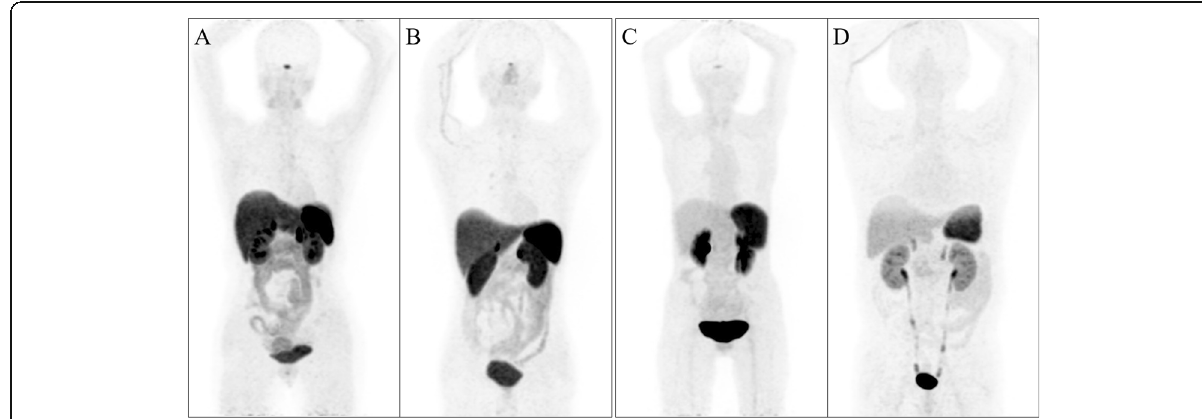
Fig. 5 Representative maximum-intensity PET/CT projection images of 68 Ga-DOTA-TATE ( a , b ) and 68 Ga-NOTA-TATE ( c , d ) in healthy volunteers 35 – 45 min after injection. a Female, 46 years old, 51 kg. Maximum intensity projection image after intravenous injection of 68 Ga-DOTA-TATE (2.52 mCi) (pituitary, SUVmax = 7.74; spleen, SUVmax = 25.5; liver, SUVmax = 9.4; kidney, SUVmax = 13.9). b Male, 37 years old, 58 kg. Maximum intensity projection image after intravenous injection of 68 Ga-DOTA-TATE (2.80 mCi) (pituitary, SUVmax = 4.2; spleen, SUVmax = 16.3; liver, SUVmax = 7.8; kidney, SUVmax = 10.5). c Female, 35 years old, 33 kg. Maximum intensity projection image after intravenous injection of 68 Ga-NOTA-TATE (1.86 mCi) (pituitary, SUVmax = 1.9; spleen, SUVmax = 6.8; liver, SUVmax = 1.4; kidney, SUVmax = 12.5). d Male, 57 years old, 83 kg. Maximum intensity projection image after intravenous injection of 68 Ga-NOTA-TATE (3.83 mCi) (pituitary, SUVmax = 0.7; spleen, SUVmax = 3.9; liver, SUVmax = 1.3; kidney, SUVmax = 6.2). Compared with 68 Ga-DOTA-TATE, 68 Ga-NOTA-TATE imaging provides a potential significant advantage in